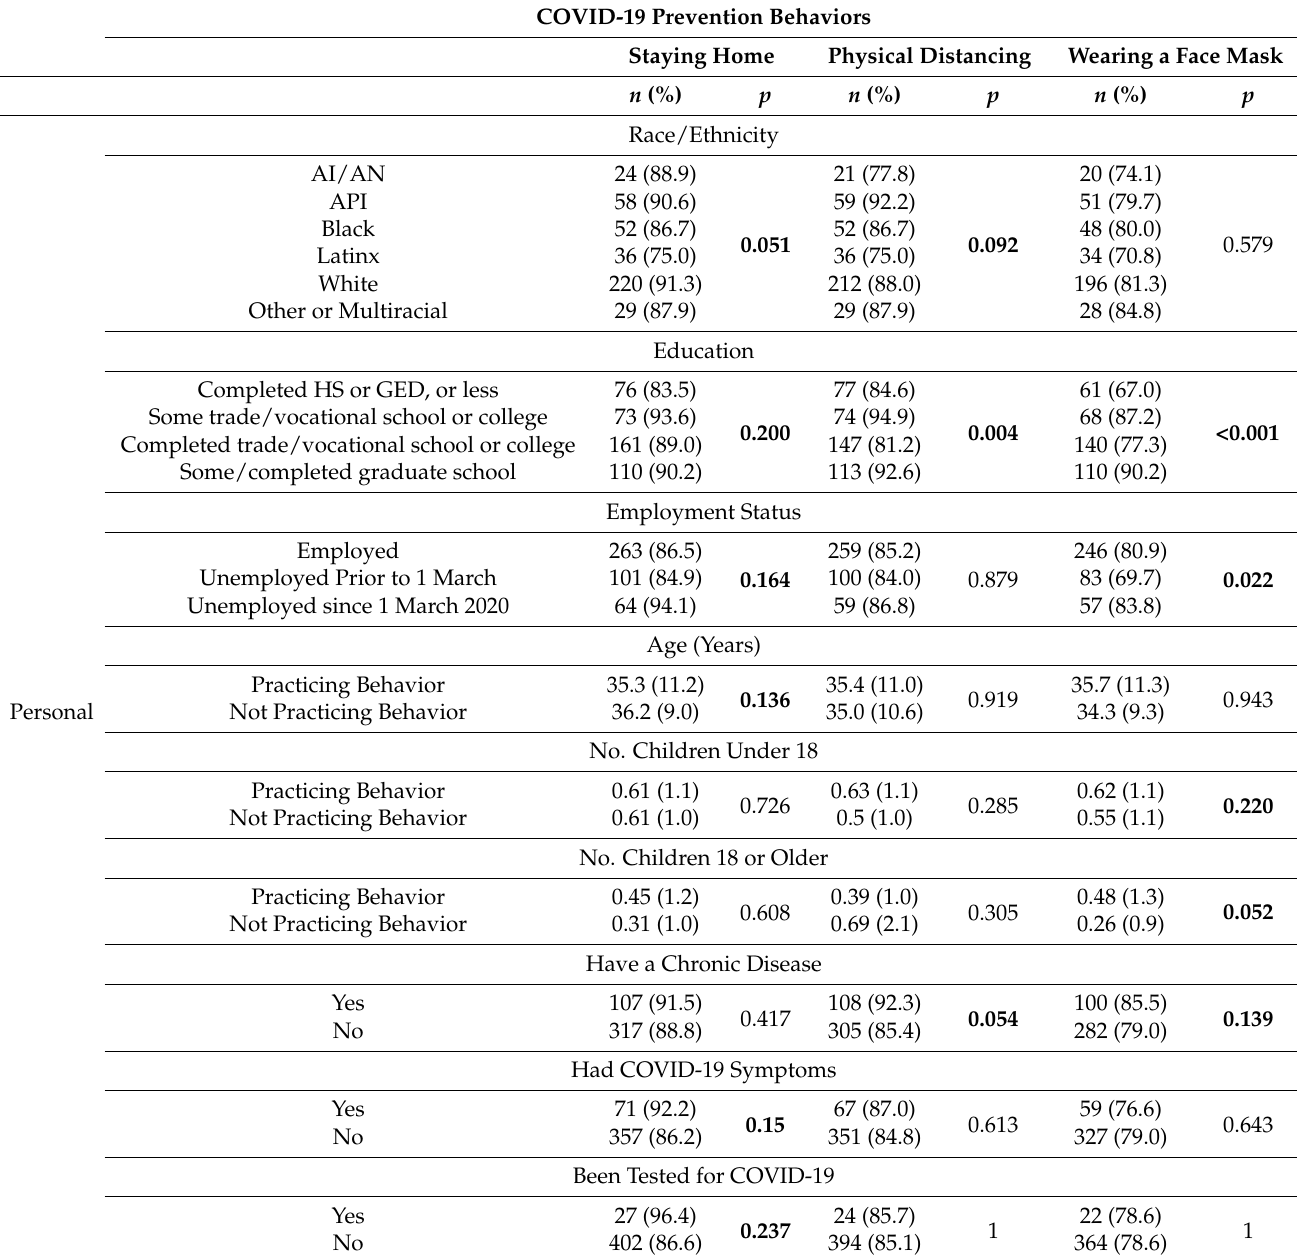
p < 0.25 (Table 2). Staying home was associated, with varying directionality, with (1) per- sonal domain factors of race/ethnicity ( p = 0.051), education ( p = 0.200), employment ( p = 0.164), age ( p = 0.136), having had symptoms of COVID-19 ( p = 0.15), having been tested for COVID-19 ( p = 0.237), knowing where to get tested for COVID-19 ( p = 0.042), and fear of COVID-19 score ( p = 0.005); (2) interpersonal domain factors of relationship type ( p = 0.005), knowing someone who was diagnosed with COVID-19 ( p = 0.042), and knowing someone who died of COVID-19 ( p = 0.148); (3) organizational domain factors of living with others ( p = 0.005), number of participants’ children under 18 staying in house- hold ( p = 0.227), and annual household income ( p = 0.001); and, (4) at the environmental level, urbanicity ( p = 0.006). Table 2. Bivariate relationships between independent and outcome variables. COVID-19 Prevention Behaviors Staying Home Physical Distancing Wearing a Face Mask n (%) p n (%) p n